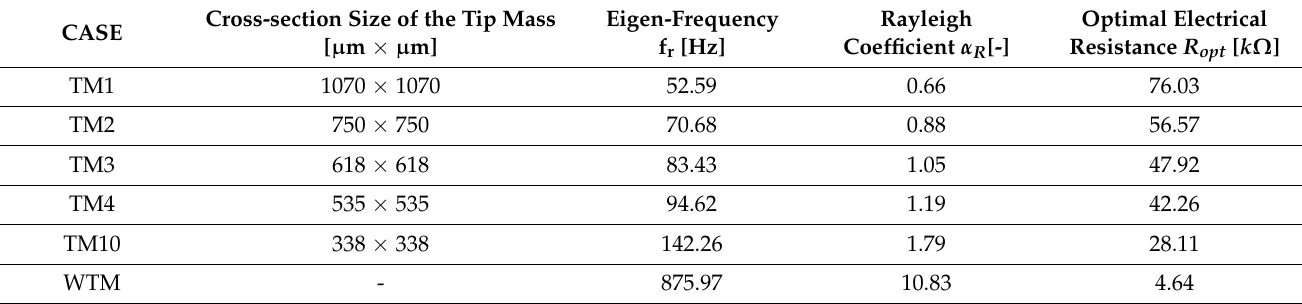
Table 3. Cases considered in the parametric